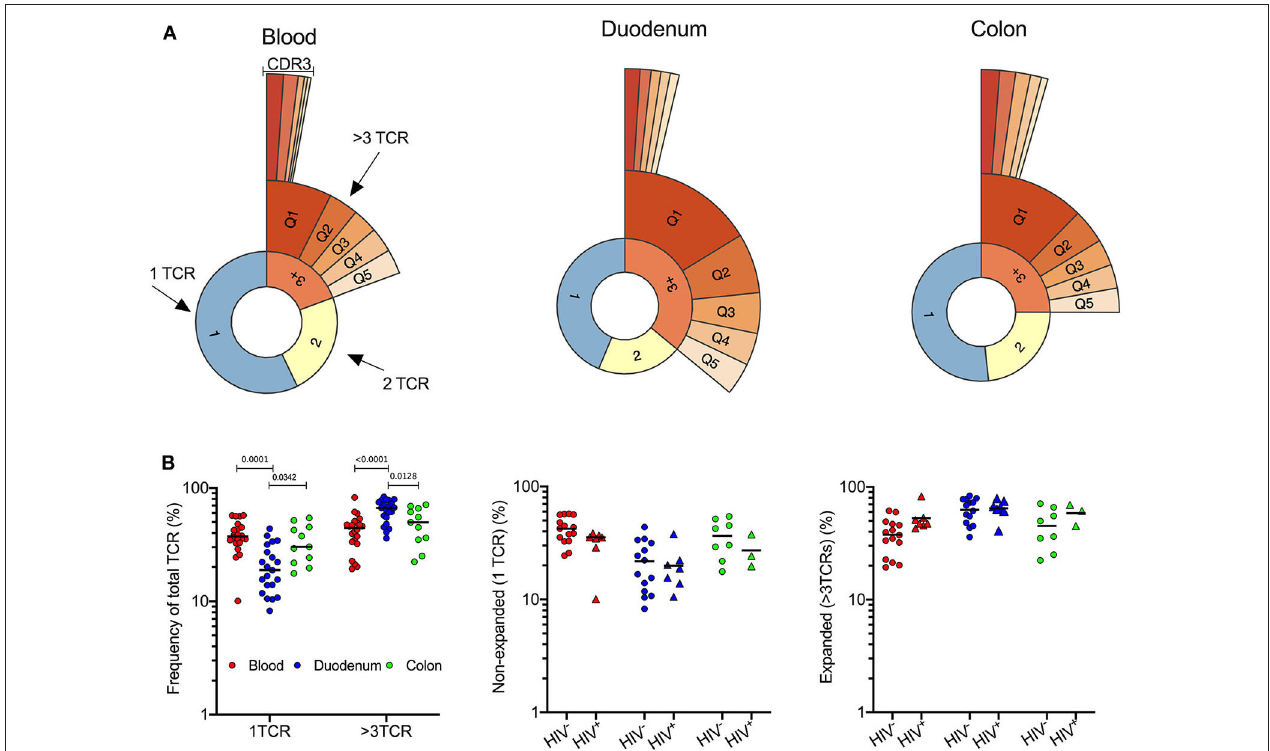
FIGURE 3 | Expansion of T-cell clones in duodenal GALT tissue. (A) Quantile plot TCR α CDR3 clonality in 1 representative sample of blood, duodenum and colon (PID 022-09-1069, 022-09-2078, and 022-09-1070 respectively; Supplementary Table 1 ). All participants were HIV –ve. (B) Left: Frequency of singular CDR3 vs. > 3 identical CDR3 of total TCRs sequenced as a measure of clonality in blood (red; n = 22), duodenum (blue; n = 21), and colon (green; n = 11) pinches. Plot includes HIV– and HIV + participants. Frequency of singular (middle) and expanded (right) CDR3 sequences in blood (red; n = 22), duodenum (blue; n = 21), and colon (green; n = 11) pinches of HIV –ve (circles; n = 37) vs. HIV + ve (triangles; n = 17) individuals. Dunn’s multiple comparisons test. Black lines represent